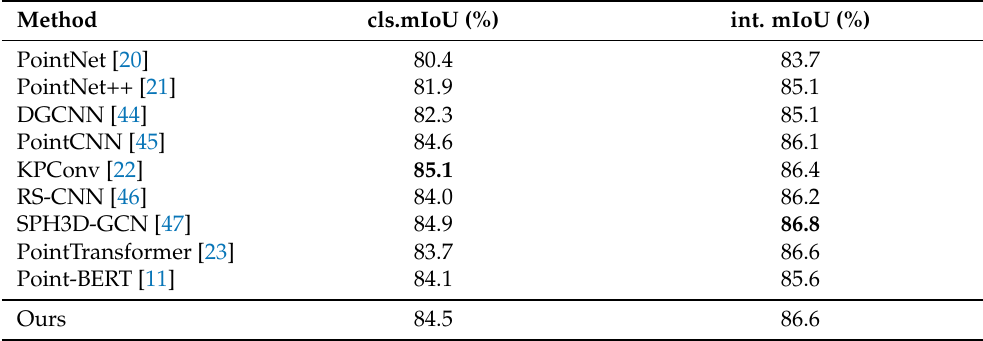
Table 1. Quantitative comparison with state-of-the-art methods on ShapeNet-part dataset. The bold denotes the best performance.